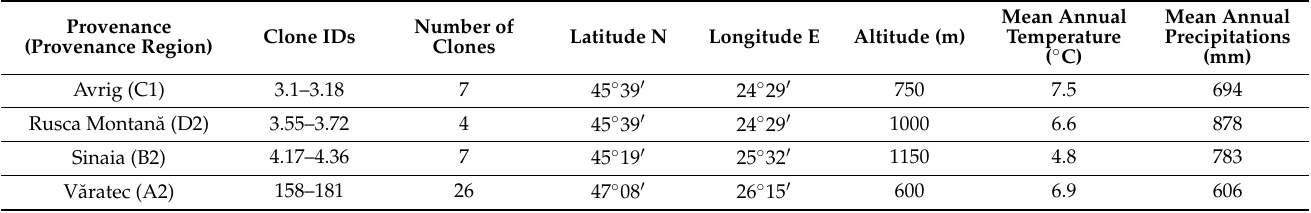
Table 1. Clone origin in the Silver fir ( Abies alba Mill.) seed